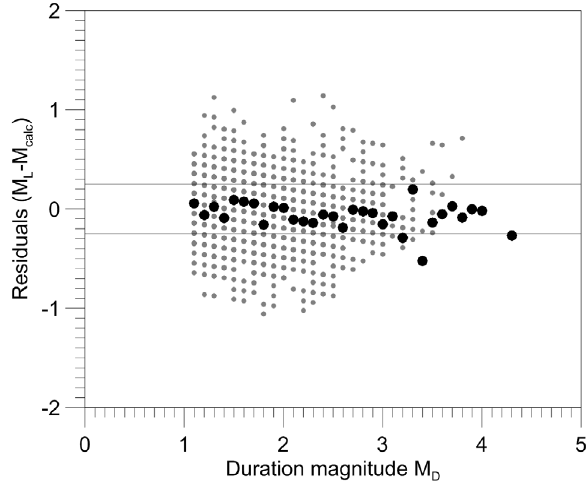
and calculated M L . Thin horizontal lines indicate the standard D -M relationship. D L